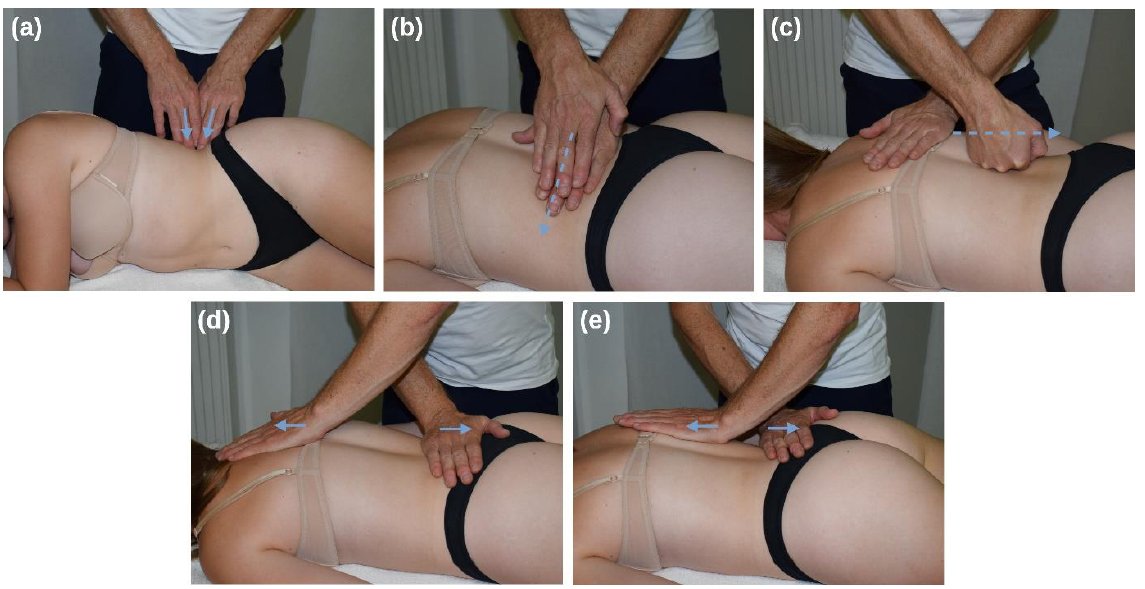
Figure 2. Myofascial release and placebo treatment at the TLF. ( a ) Sustained manual pressure to the lateral. ( b ) Lateral stretching of the TLF. ( c ) Longitudinal glide along the lumbar paravertebral muscles. ( d ) Longitudinal stretch of the TLF. ( e ) Unilateral longitudinal stretch of the TLF. Blue arrows show the direction of tissue stretching in the myofascial release treatment. In the placebo treatment, the hands were instead left in place with minimal pressure.